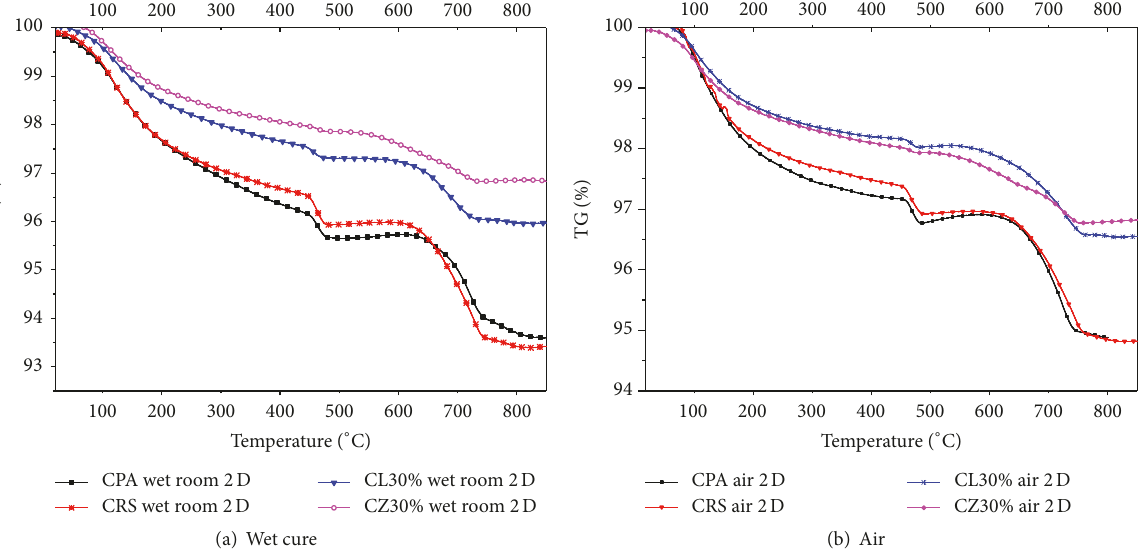
Figure 8: (a), (b) Thermogravimetric analysis of cement paste preserved in wet cure and stored in the air for 2